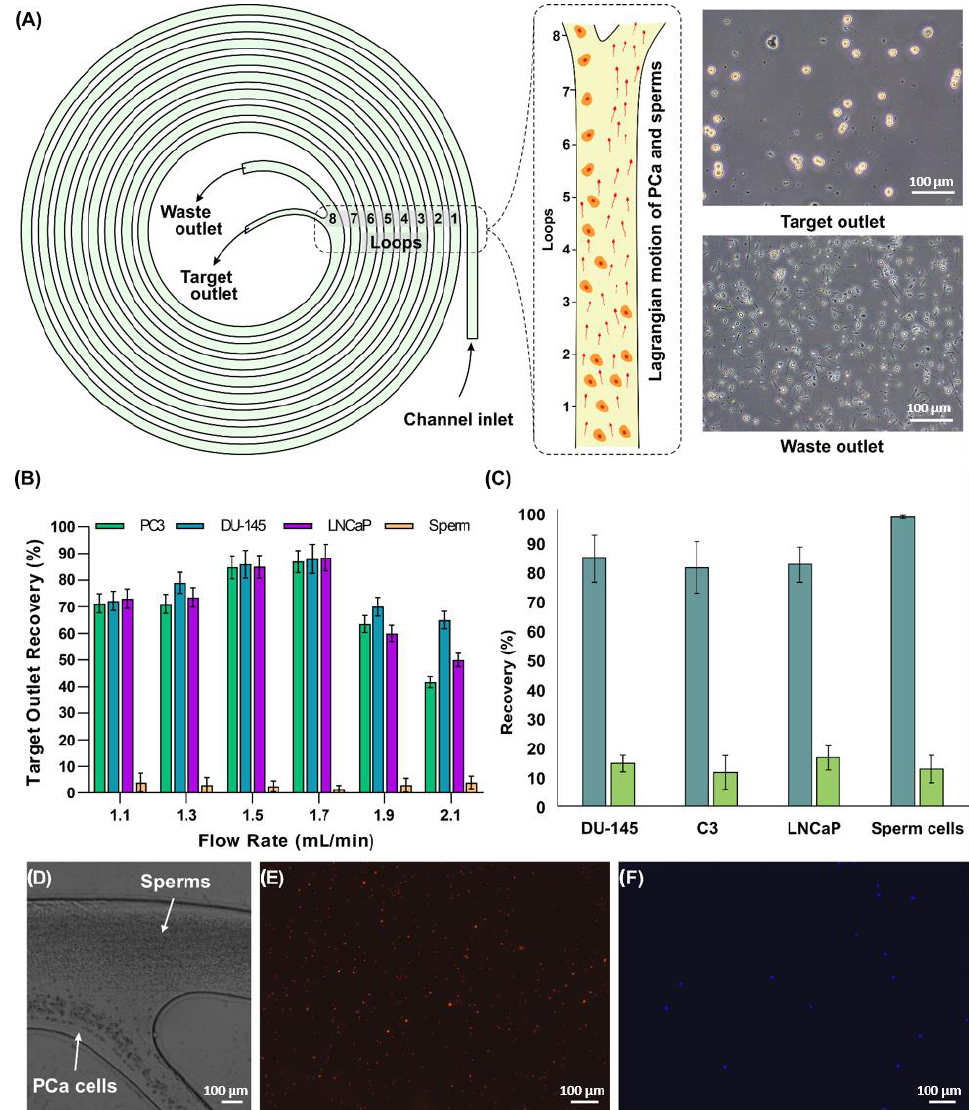
Figure 2. ( A ) Schematic representation of the spiral microfluidic channel for isolating CTCs from the SF. First, a preliminary prepared SF sample from a PCa patient is provided into the microchannel through the inlet under a continuous fluid flow at 1.7 mL/min. As a result, the SF sample is divided into target fraction containing most of the tumor cells and waste fraction containing most of the sperm cells. ( B ) Recovery rates of spiked PC3, DU-145, LNCaP cells, and sperm cells at different flow rates. ( C ) Recovery rates of spiked PCa tumor cells from three different cell lines (DU-145, PC3, and LNCaP) and sperm cells, after first and second runs of the device. The first run of the device implied the initial processing of the SF sample through the microfluidic chip. Thus, after the first run, it was possible to isolate more than 82% on average of the tumor cells, while more than 99% of the sperm cells could have been removed. The second run of the device implied processing of the target fraction. The processing of the target fraction resulted in a loss of the tumor cells and removal of the sperm cells in comparable percentages, at an average of 15% from the total number of tumor and sperm cells presenting in the target fraction. ( D ) High-speed camera image of CTC isolation from SF at the bifurcation point of the microfluidic channel. ( E , F ) Fluorescent images of target and waste fractions, respectively, showing a high concentration of DU-145 cells (blue dots) in the target fraction, and primarily sperm cells (red dots) in the waste fraction. SF samples from the group of 15 patients with diagnosed PCa at its localized stage, and from 15 healthy males aged from 18 to 30 years as a control group, were acquired. Cells collected from the target outlet of the device were considered CTCs if they were more than 13 µm in mean diameter; featured the cytoplasm area at more than 232 µm 2 determined from measurements of DU-145 and PC3 cells of the mean area of (284 ± 52) µm 2 ; had the cell nucleus mean area at more than 92 µm 2 , measured from DU-145 and PC3 cells; and were positive for three antigens: CK (CK+), PSMA (PSMA+), and GPC-1 (GPC-1+). CK+, PSMA+, and GPC-1+ are defined as the cells exhibiting a fluorescence sig- nal of more than 1572, 1589, and 1150 arbitrary units, respectively. The confirmation val- ues were based on the mean fluorescent intensities of DU-145 and PC-3 cells measured as 1771 ± 199, 1867 ± 278, and 1423 ± 273 for the corresponding antigens, respectively.